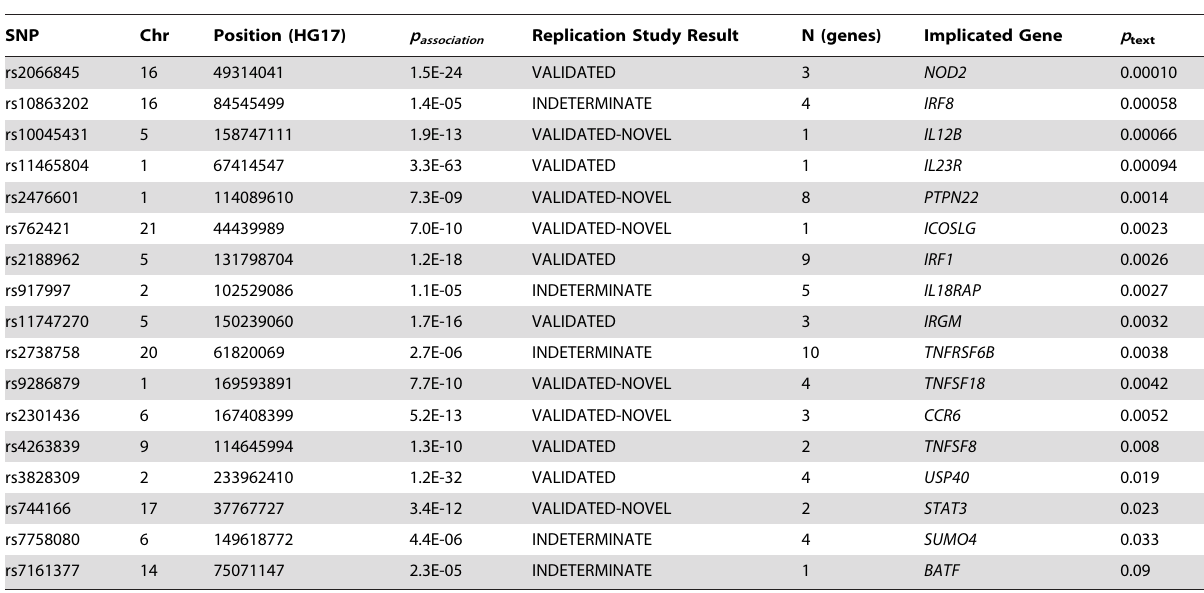
Table 2. High scoring regions from a Crohn’s disease GWA